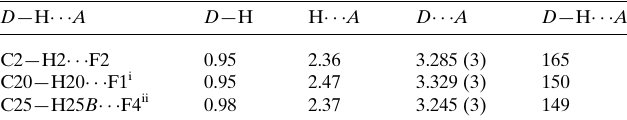
Table 1 Hydrogen-bond geometry (A˚ , (cid:5) ).